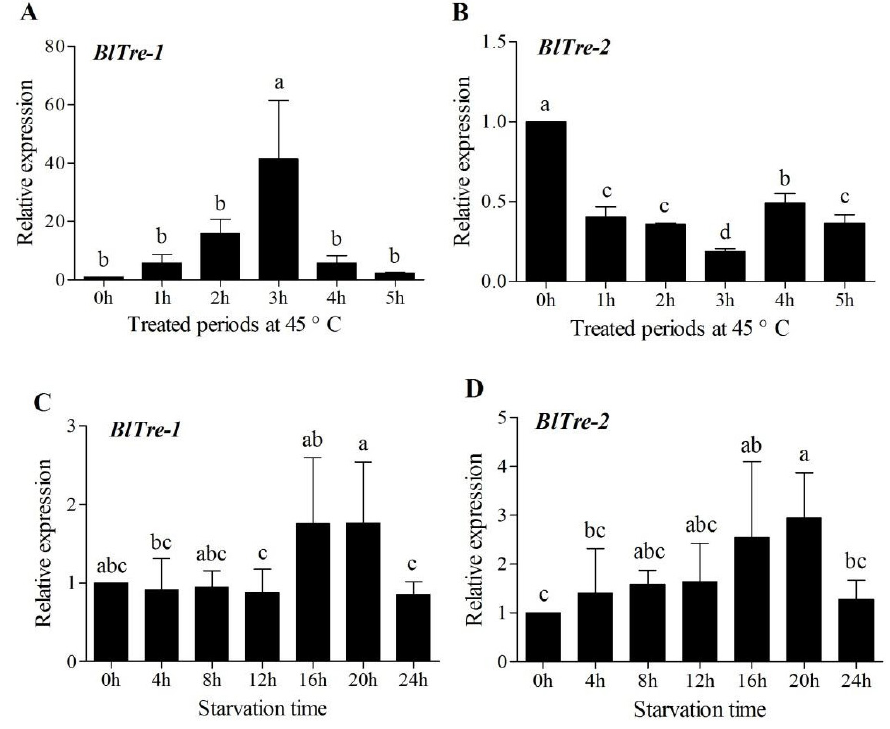
Fig 5 . The relative expression levels of two trehalase genes under adverse conditions. The BlTre-1 and BlTre-2 relative expression in workers which were exposed to 45°C ambient temperature for 0, 1, 2, 3, 4 and 5 h (A, B). The BlTre-1 and BlTre-2 relative expression in workers which were starved for 0, 4, 8, 12, 16, 20 and 24 h (C, D). Each value represents the mean ± S.D., and different letters above the bars indicate significant differences ( p